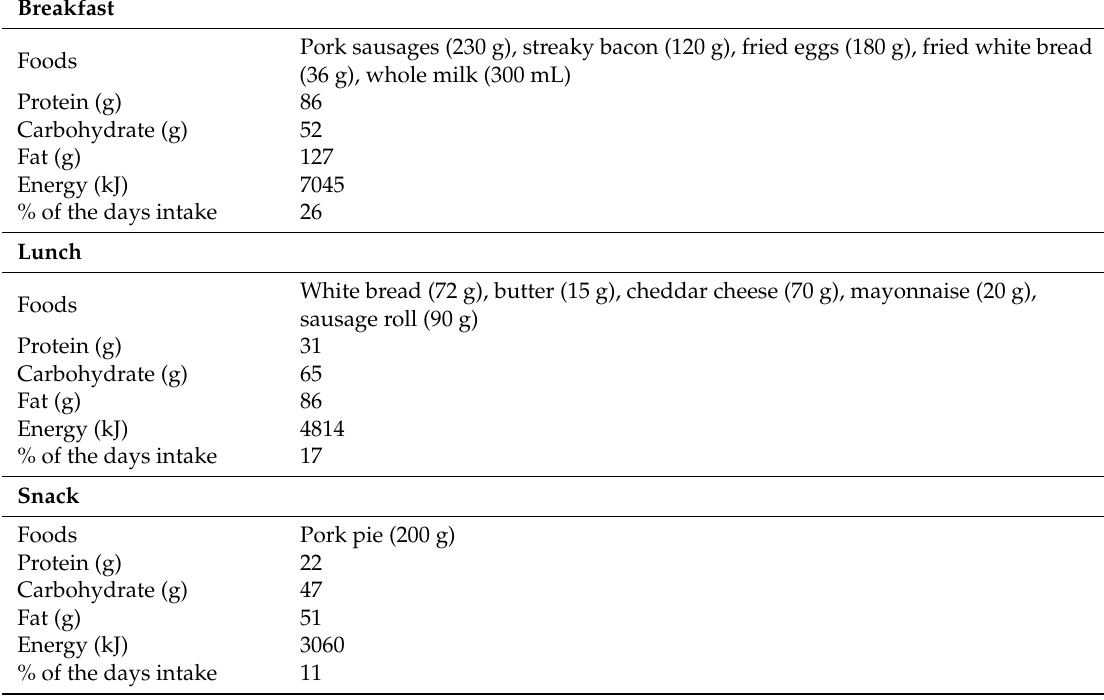
Table A1. Example diet plan for one of the